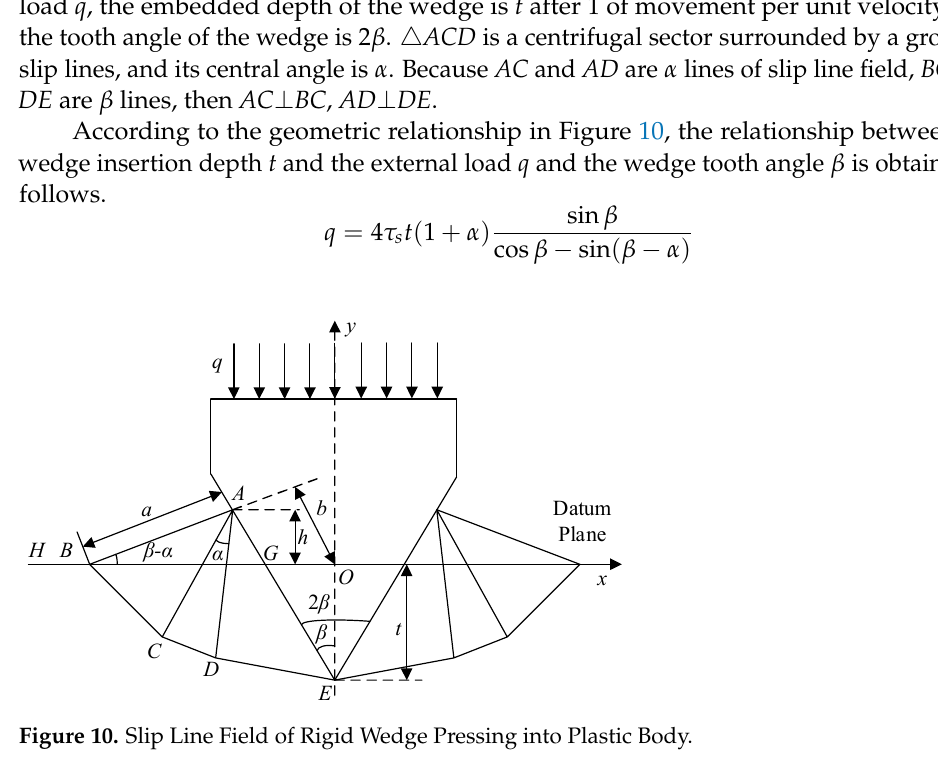
Figure 9. Pressure Model of Rigid Wedge.